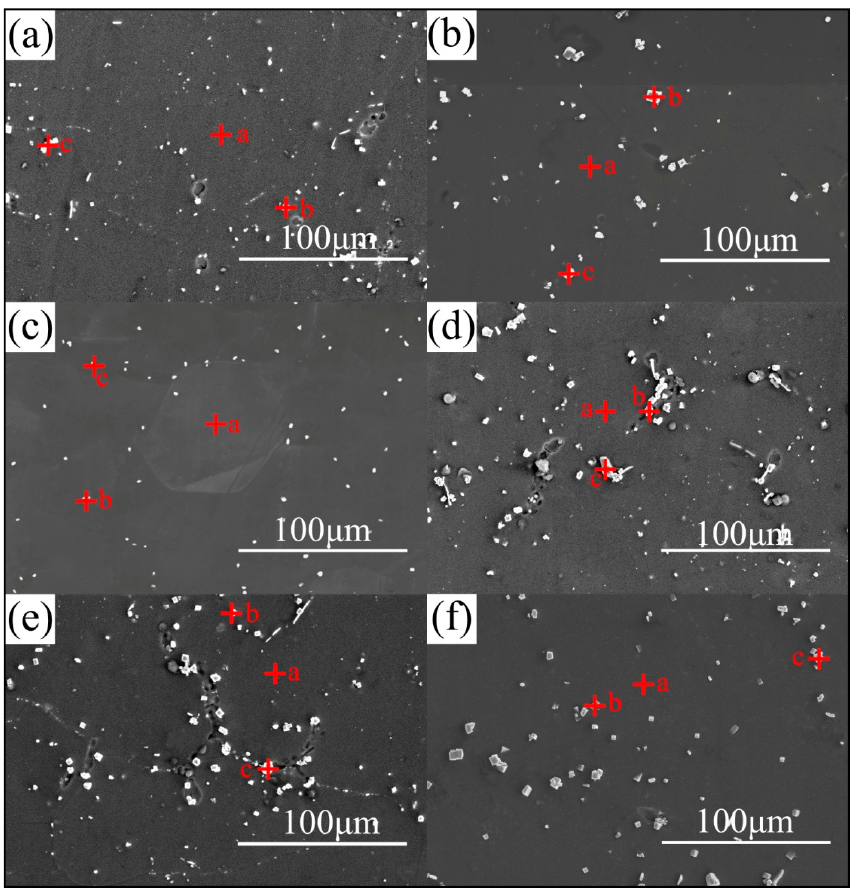
Figure 4. Close-up views of different samples: ( a ) T4-air quenching; ( b ) T4-water quenching; ( c ) T4-cryogenic quenching; ( d ) T6-air quenching; ( e ) T6-water quenching; and ( f ) T6-cryogenic quenching. Table 2. Energy dispersive X-ray spectroscopy (EDS) results of different samples in Figure 4.